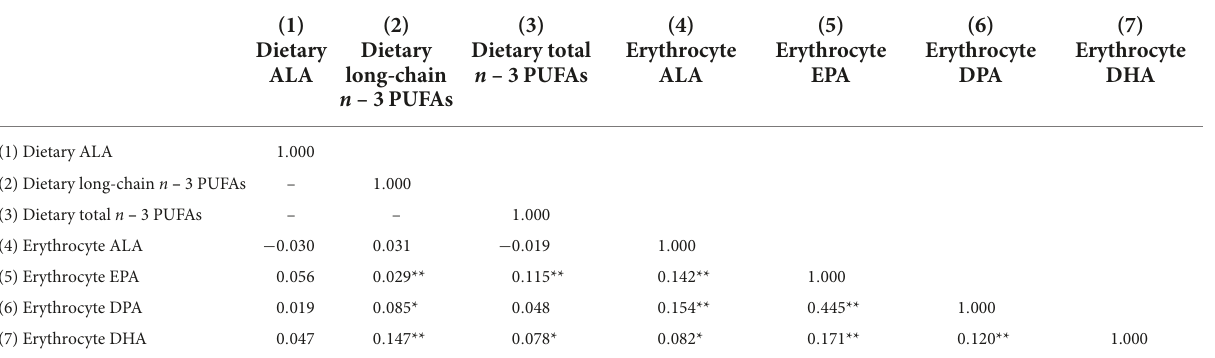
TABLE 3 Correlations between dietary and erythrocyte n – 3 PUFAs in control